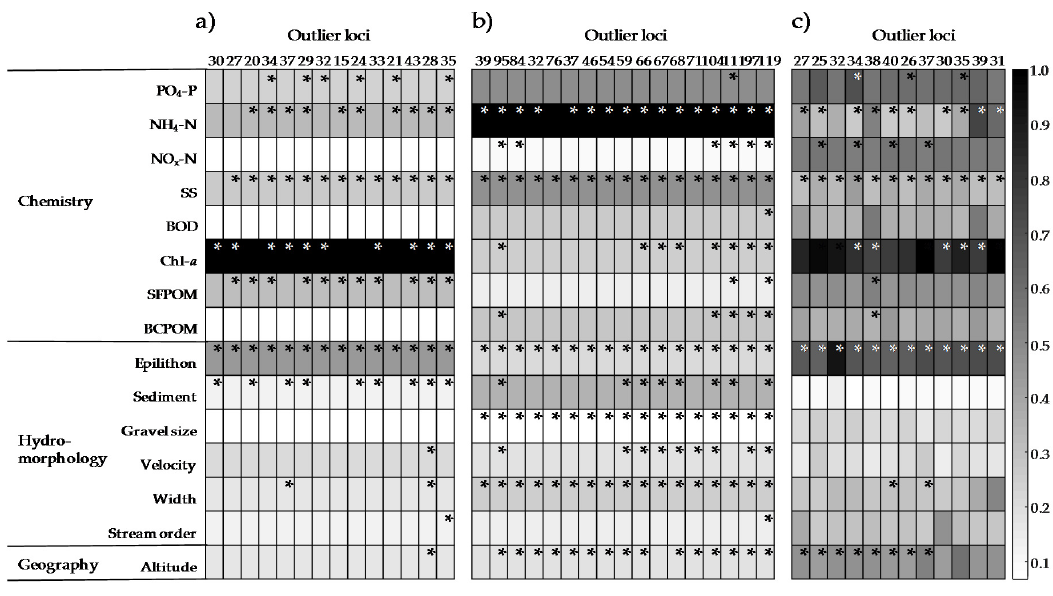
Figure 9. Environmental responsiveness in association with outlier loci in Hydropsyche albicephala ( a ); Stenopsyche marmorata ( b ); and Hydropsyche orientals ( c ). The gray levels indicate the E k ’ value according to the maximum across environmental variables in each species ( H. albicephela : Chl- a (1.28), S. marmorata : NH 4 –N (0.76), and H. orientalis : Chl- a (0.22)). The asterisk at the upper right corner of each cell indicates the significance ( p < 0.05) of environmental variables according to the Kolmogorov-Smirnov test. For convenience of visualization, white asterisks are listed when E k ’ is equal to or greater than 0.6; otherwise there is black asterisk.